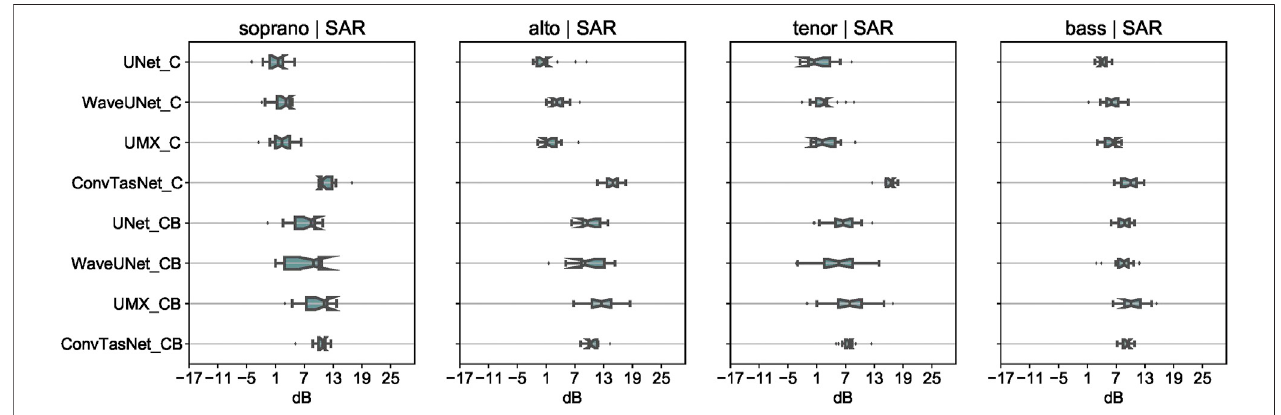
FIGURE 5 | Boxplot SAR results for the Choir case models trained on CSD ( modelname C ) and CSD + BCD ( modelname CB ).